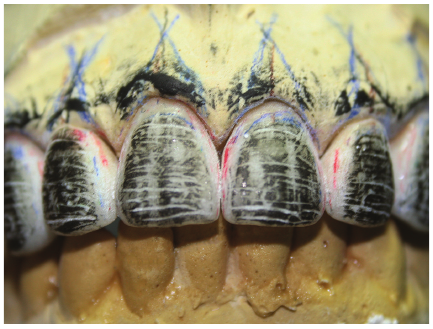
Figure 7: Surface texture reproduction with graphite.